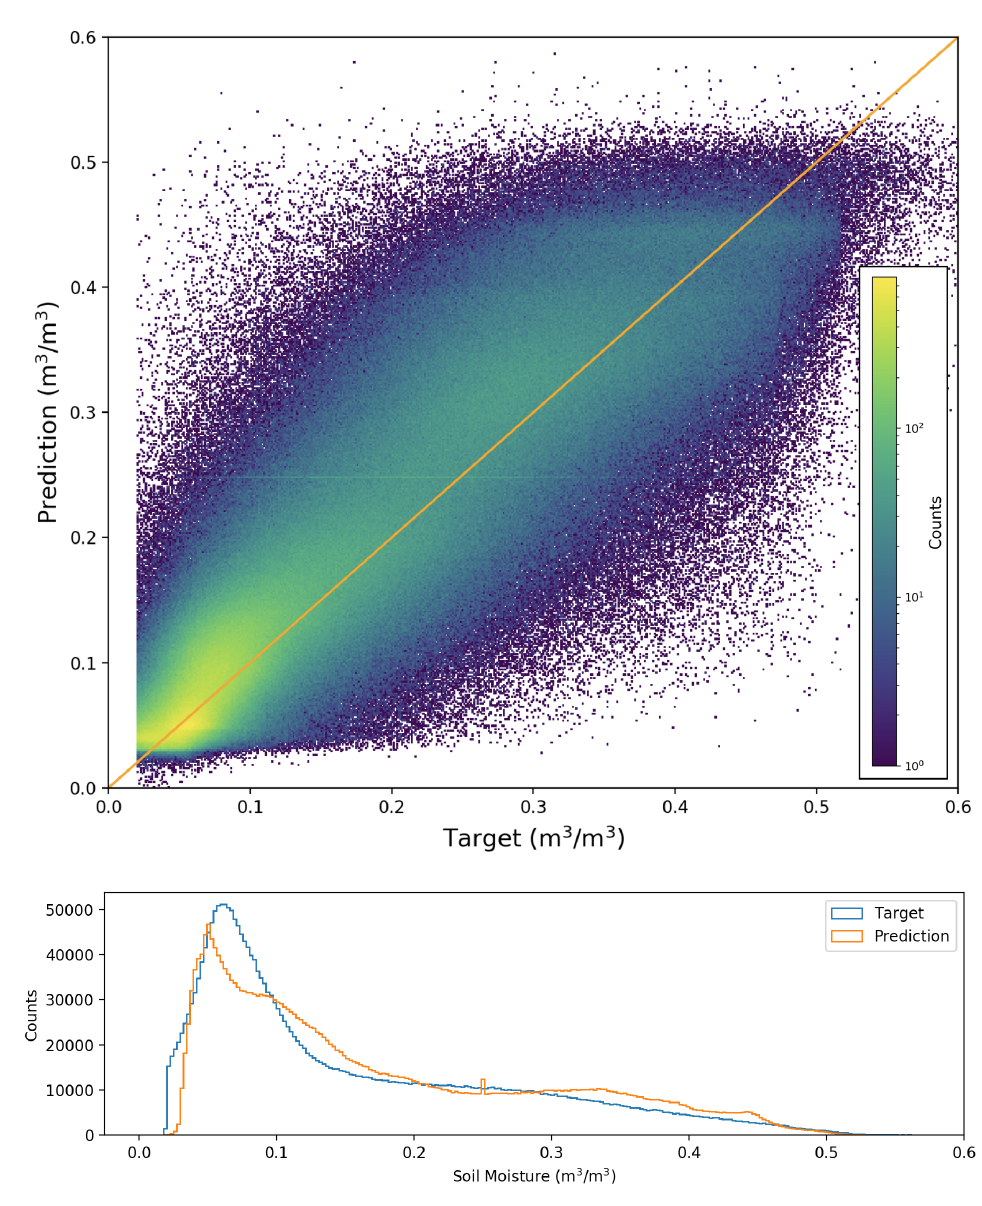
Figure 9. ( Top ) Results from an example training session showing the correlation between predic- tion/target where color is on a logarithmic scale. Orange line highlights ideal correlation. ( Bottom ) Comparison of prediction and target